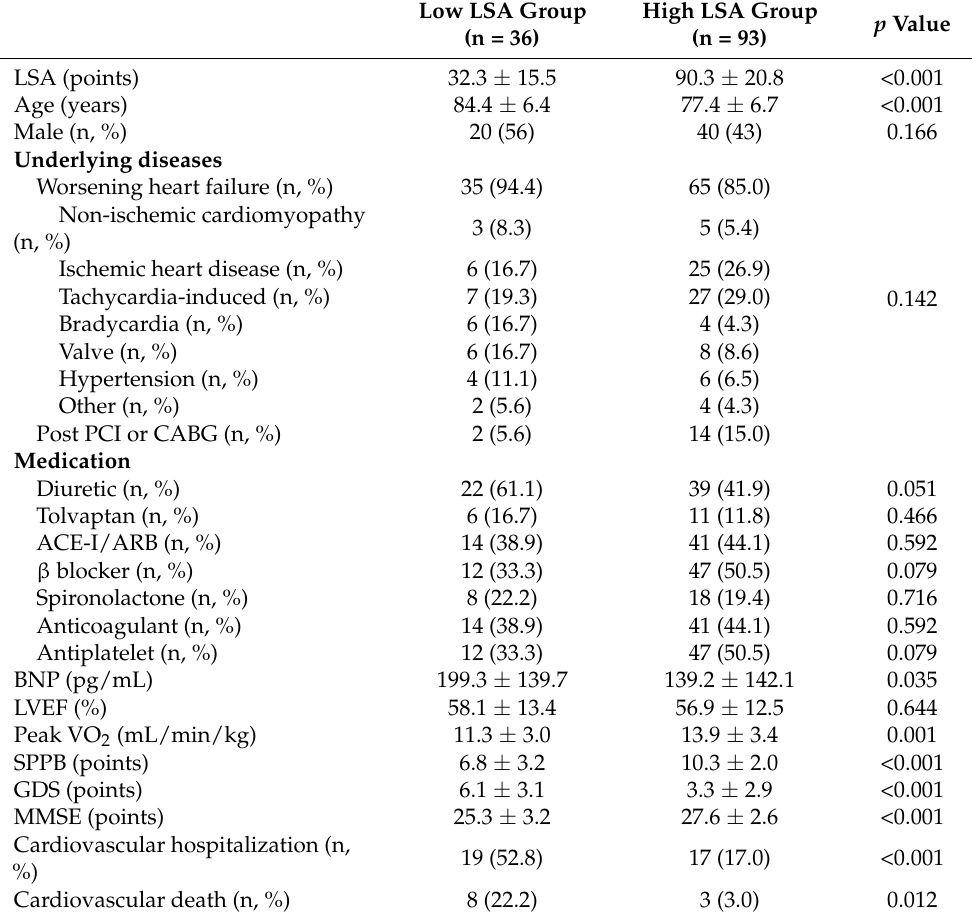
Table 2. Comparison of baseline clinical characteristics between the low and high LSA